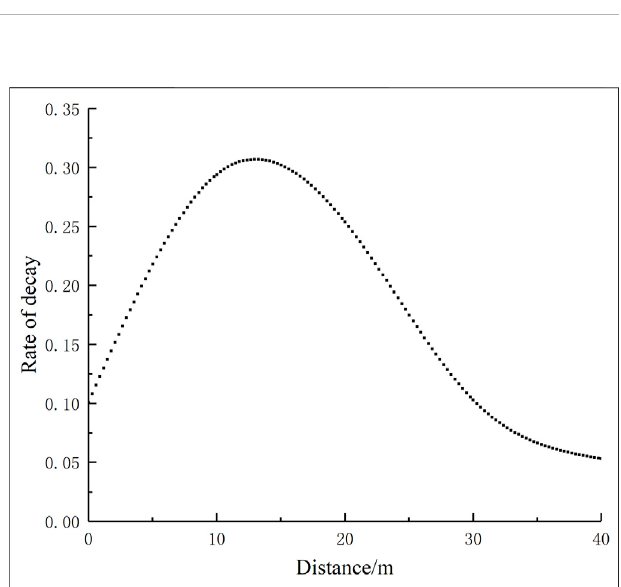
FIGURE 16 | Variation curve of attenuation rate of overpressure peak at every 20 m in working face.